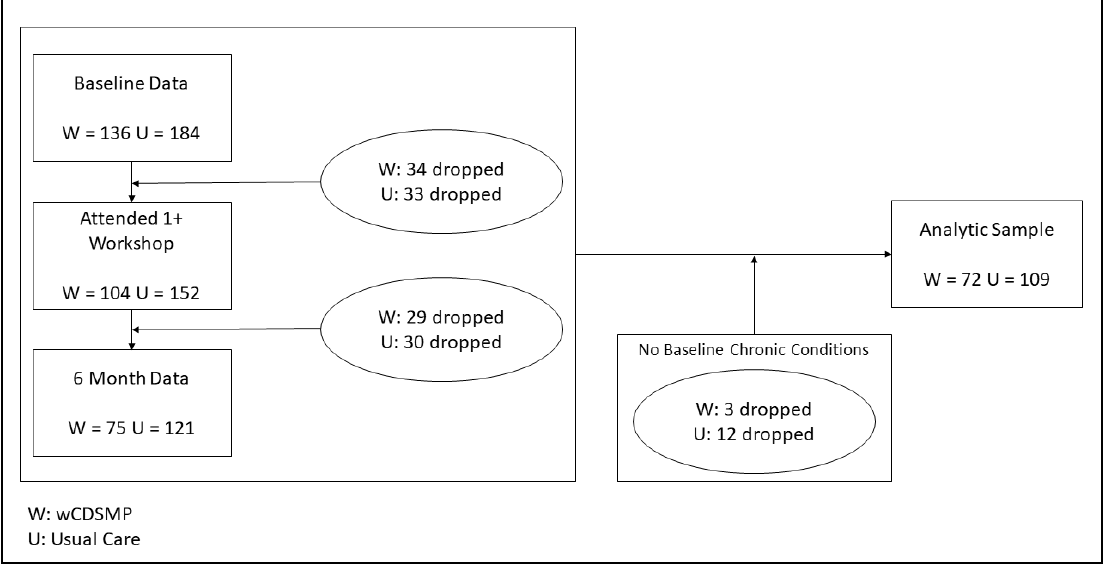
Figure 1. CONSORT diagram depicting participant flow. Table 2. Sample characteristics by intervention condition.